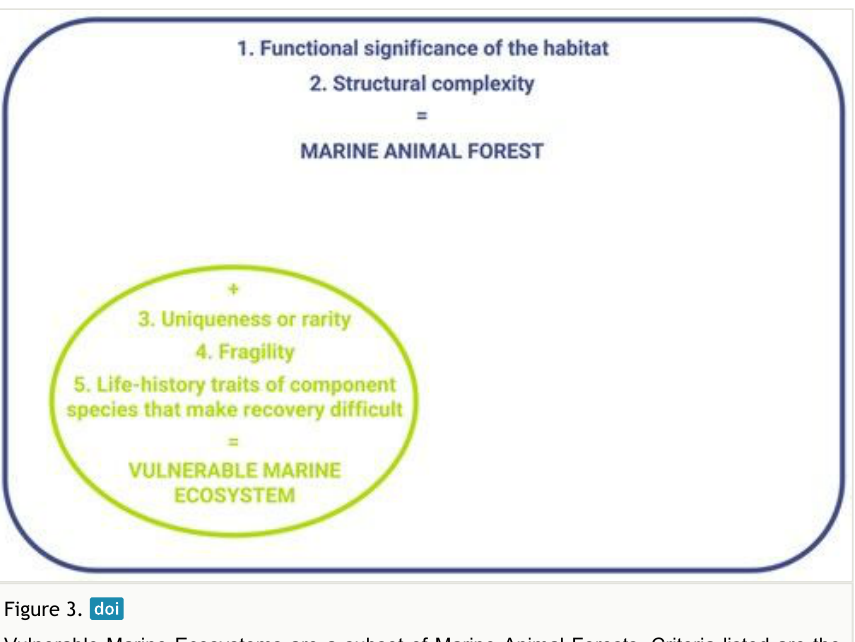
Vulnerable Marine Ecosystems are a subset of Marine Animal Forests. Criteria listed are the five criteria for VMEs given by FAO